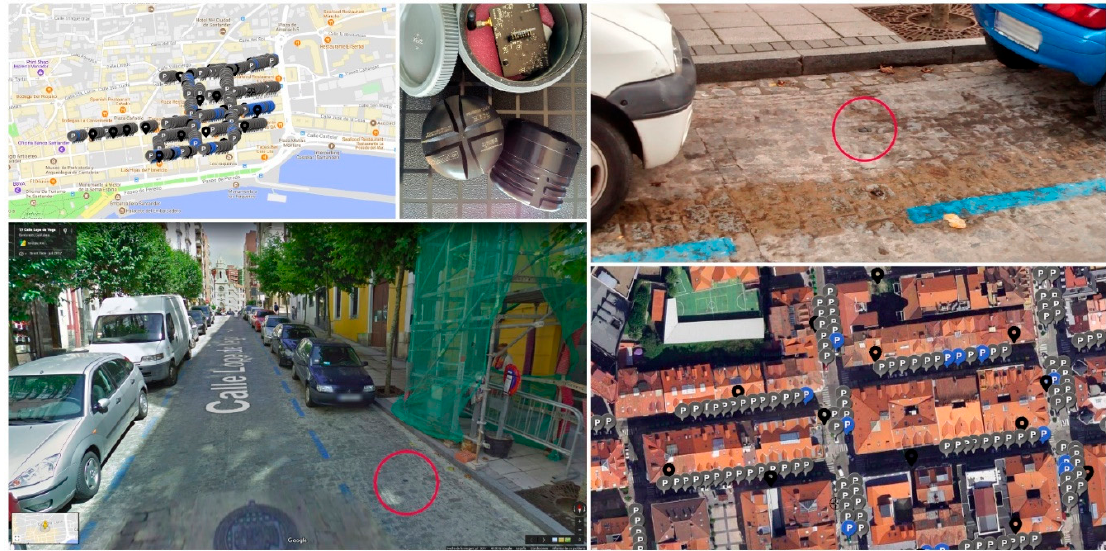
Figure 5. Santander Smart parking infrastructure in the city center area.